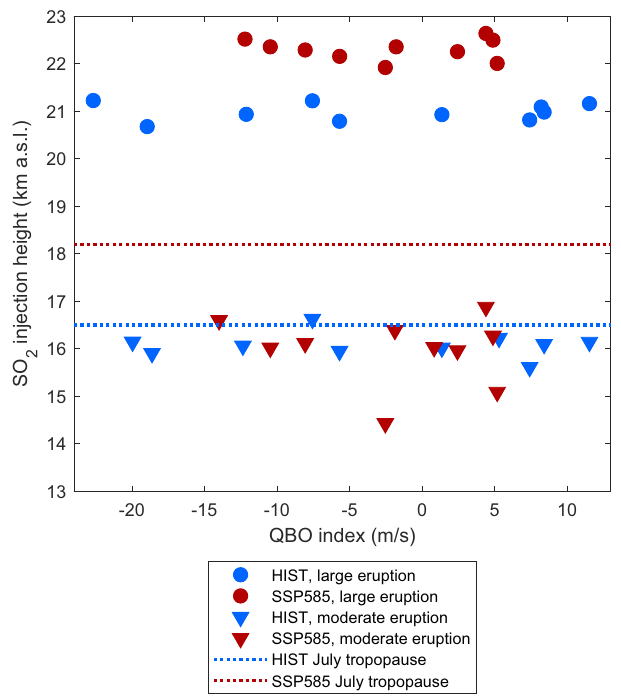
Fig. 2 Initial conditions in the UK Earth System Model (UKESM) simulations conducted. SO 2 injection height (km) as a function of the quasi-biennial oscillation (QBO) index (m s − 1 ) for the HIST (blue, historical climate) and SSP585 (red, high-end future climate) experiments. Dashed lines show the July-mean tropopause height at the eruption location (15.1° N,120.4°E) for the two climates. The QBO index was de fi ned as the average zonal wind at 30 hPa between 15°S and 15°N. The injection height shown is the center height of the injection (see Methods